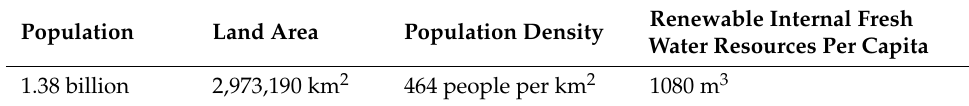
Table 1. Basic population, land area, and water data for India.